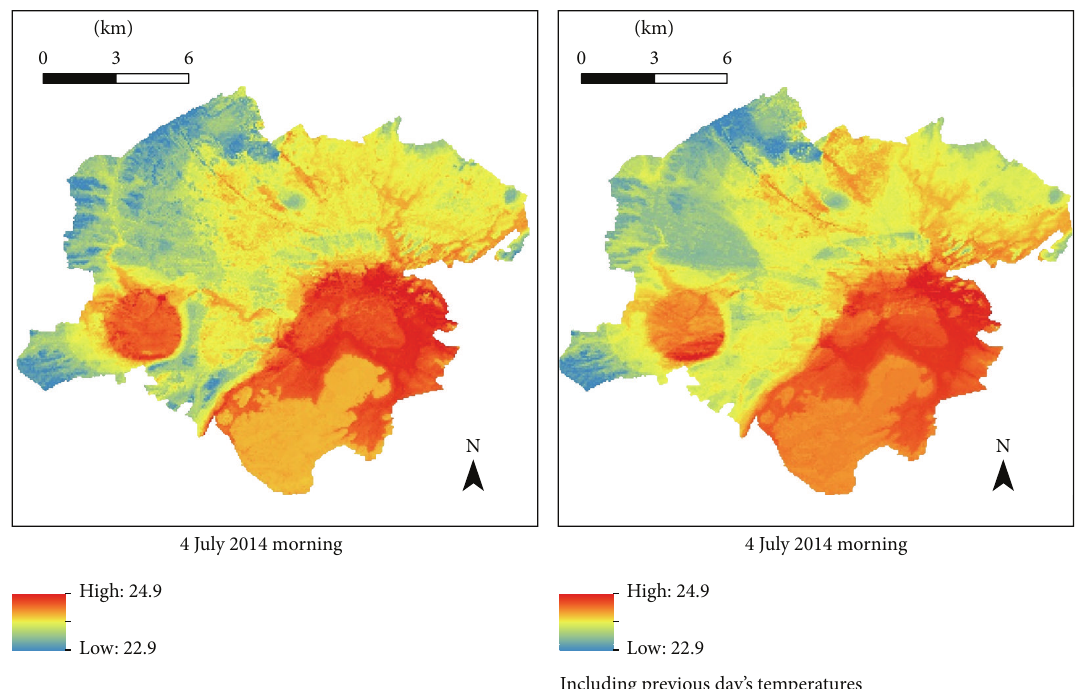
Figure 15: Estimated temperatures ( ∘ C) for 4 July 2014 morning. Left image does not include lag-1 variable and right image includes lag-1